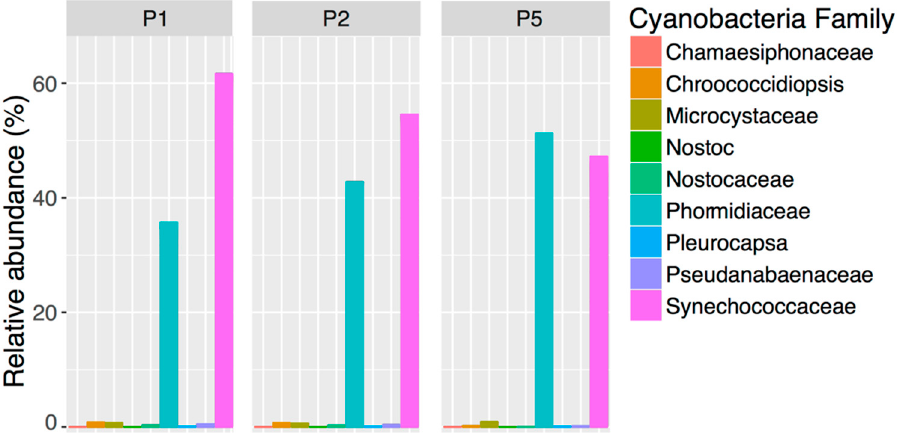
Figure 8. Relative abundance (%) for Cyanobacteria families. Family-level relative abundances are calculated for the Cyanobacteria phyla only, not relative to all the bacterial taxa measured. See Appendix A Table A7 for the relative abundance values. P1 = Pond 1, P2 = Pond 2 and P5 = Pond 5.